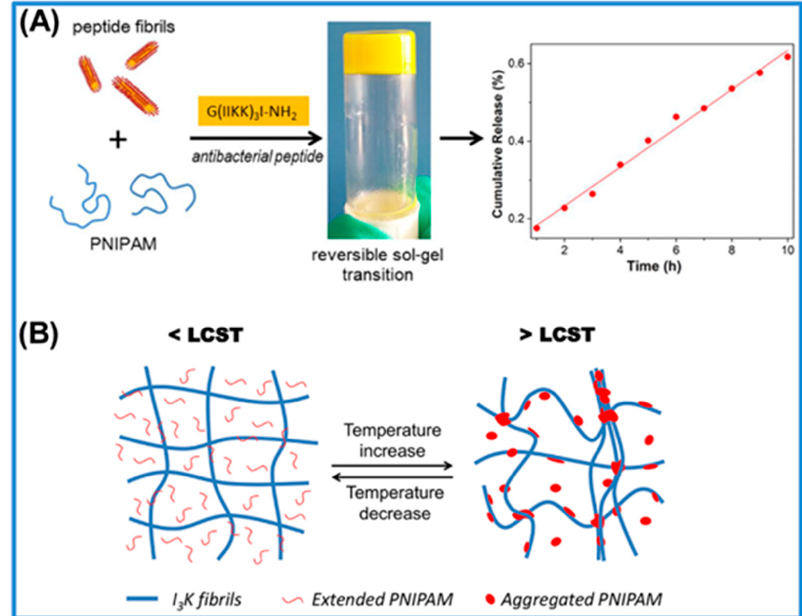
Figure 2. ( A ) Preparation of the thermoreversible peptide / PNIPAM mixed hydrogels and loading of antibacterial peptide G(IIKK) 3 I-NH 2 for controlled release. ( B ) Schematic diagrams of the proposed states of the I 3 K / PNIPAM networks at temperature either below or above the PNIPAM LCST. Adapted with permission from Ref. [92]. Copyright (2019) American Chemical Society.